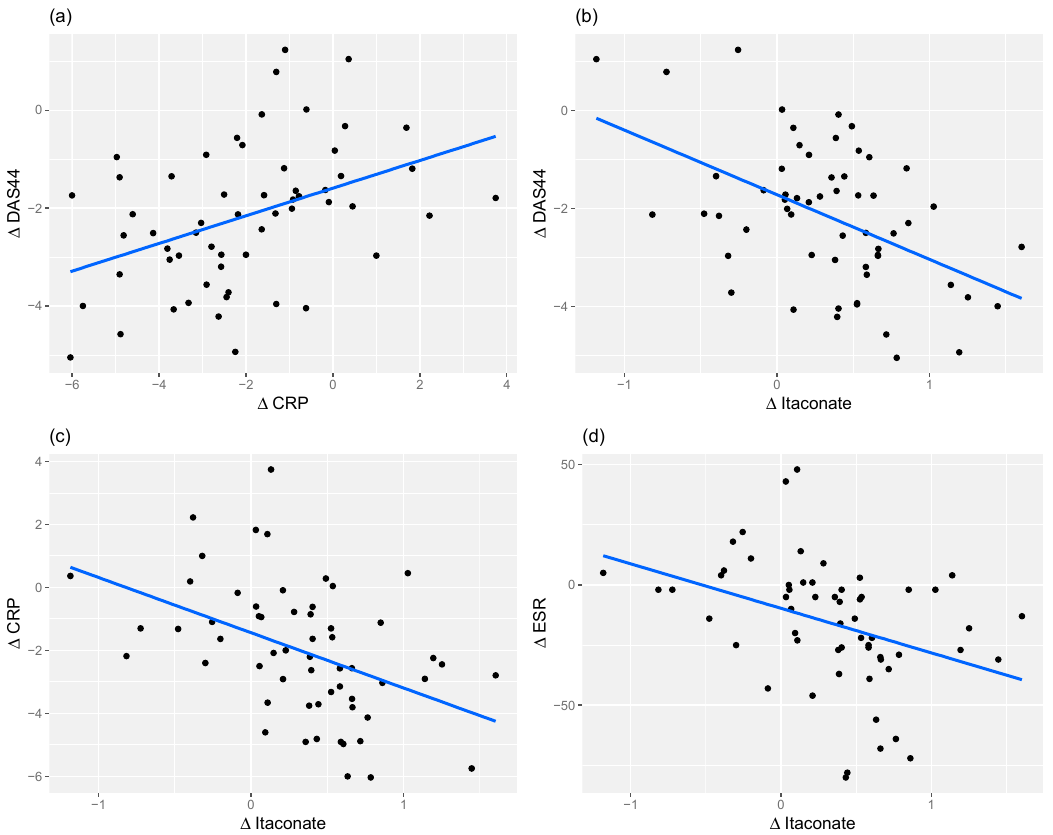
Figure 4. Scatter plots showing correlation between ( a ) change in CRP between baseline and 3 months vs. change in DAS44 between baseline and 3 months ( r = 0.41); ( b ) change in itaconate between baseline and 3 months vs. change in DAS44 between baseline and 3 months ( r = − 0.49); ( c ) change in itaconate level between baseline and 3 months vs. change in CRP between baseline and 3 months ( r = − 0.44); ( d ) change in itaconate between baseline and 3 months vs. change in ESR between baseline and 3 months ( r = −